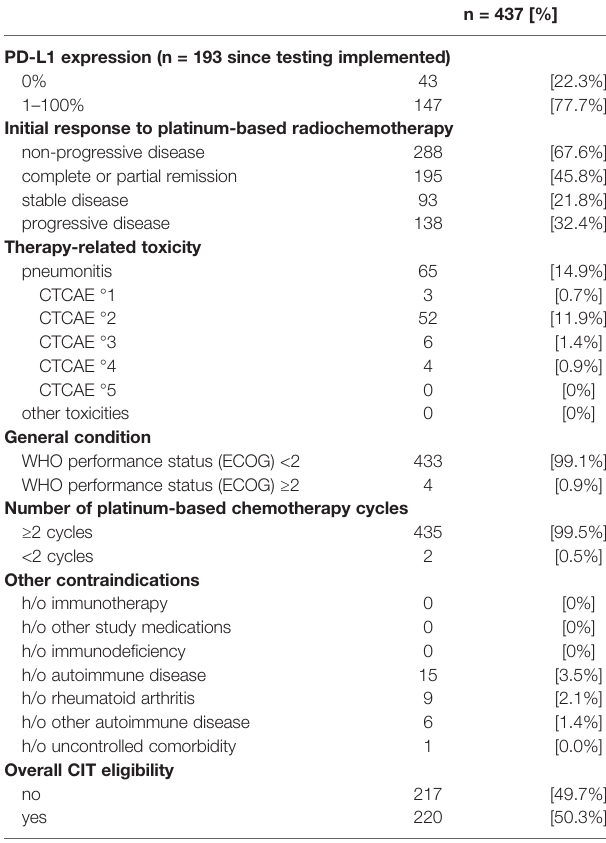
CTCAE, Common Terminology Criteria for Adverse